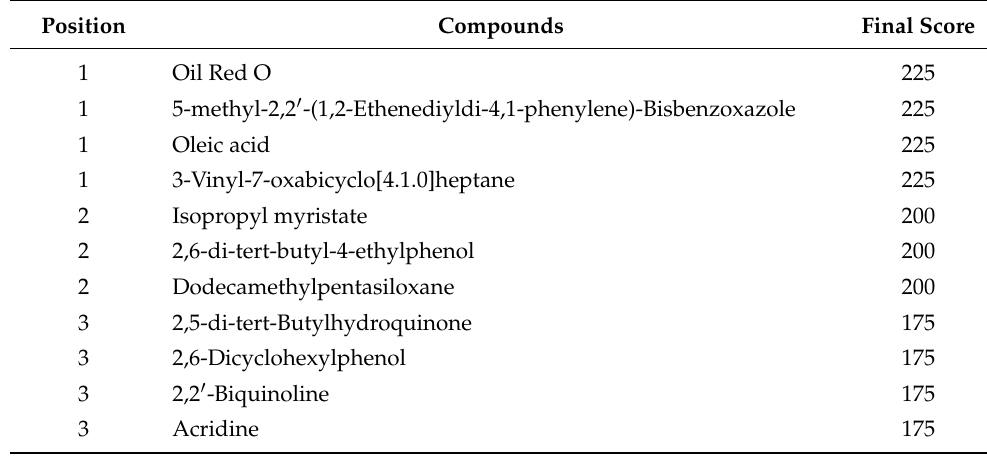
Table 1. Final ranking for the 5 highest-punctuation